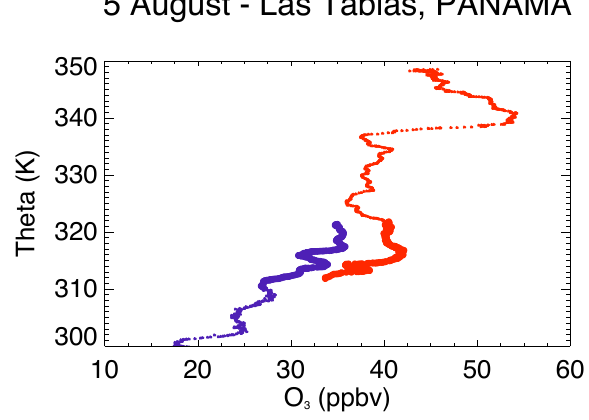
Fig. 11. Ozone vs. potential temperature for the first and last ascents of the flight of 5 August 2007 shows that the changes cannot be due to descent of the air mass alone.